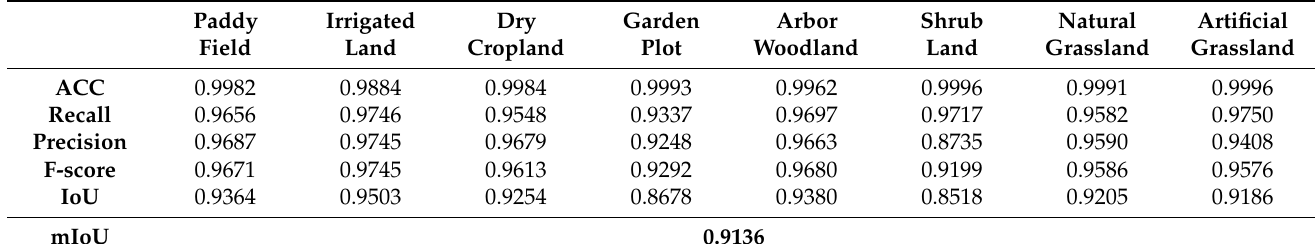
Table 3. Experiment results of the GID dataset for 8 vegetation subclasses by VEDAM.